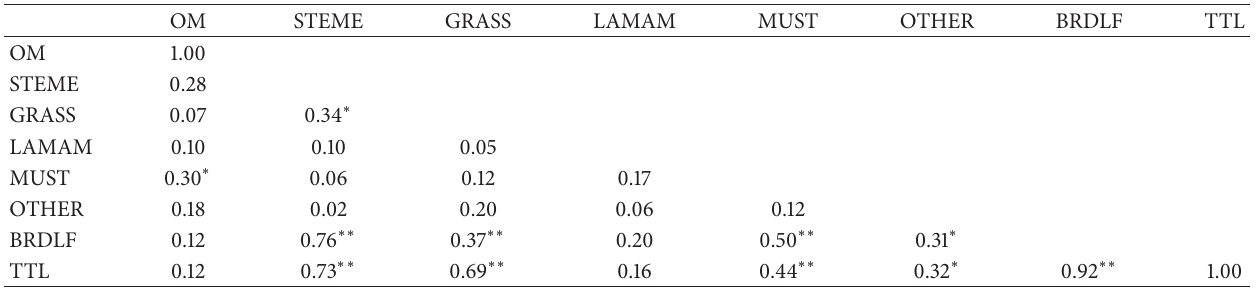
Table 2: Coefficients of correlation between organic matter and weed data, Puyallup, WA 2011. OM = organic matter, STEME = Stellaria media , GRASS = total grass, LAMAM = Lamium amplexicaule , MUST = mustard species, BRDLF = broadleaf weeds, and TTL = total weeds.